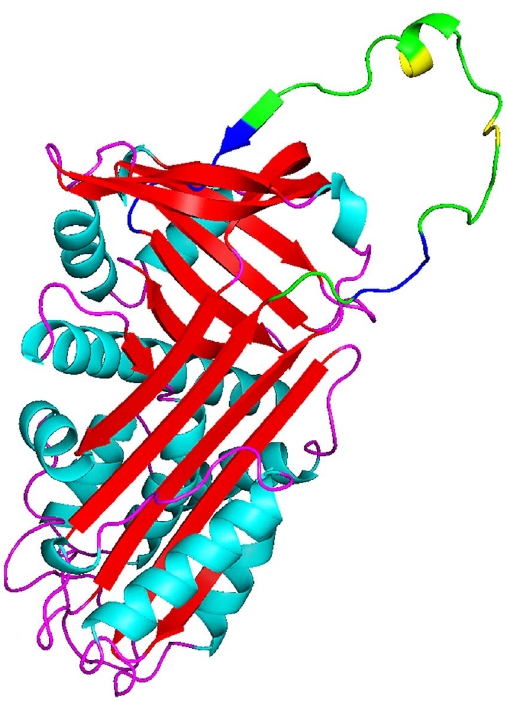
Figure 6. The predicted three-dimensional structure of SW-AT- 1. SERPIN Domains was depicted as green, reactive site was depicted as yellow, and mutant sites were depicted as blue. The N and C termini were labeled as N and C, respectively. The structrue was generated using Open-Source PyMOL (v1.4), using Manduca sexta Serpin-protease 1K complex (1SEK) as the template.